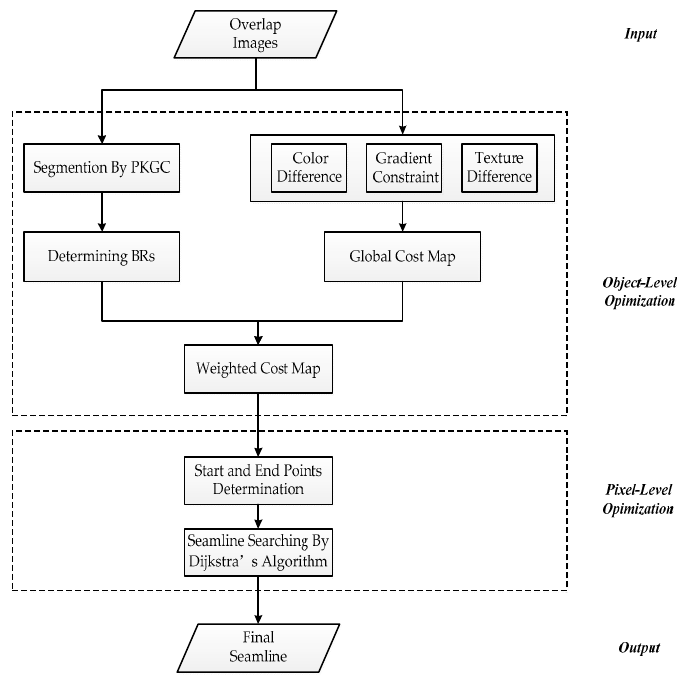
Figure 1. Flowchart of seamline determination.